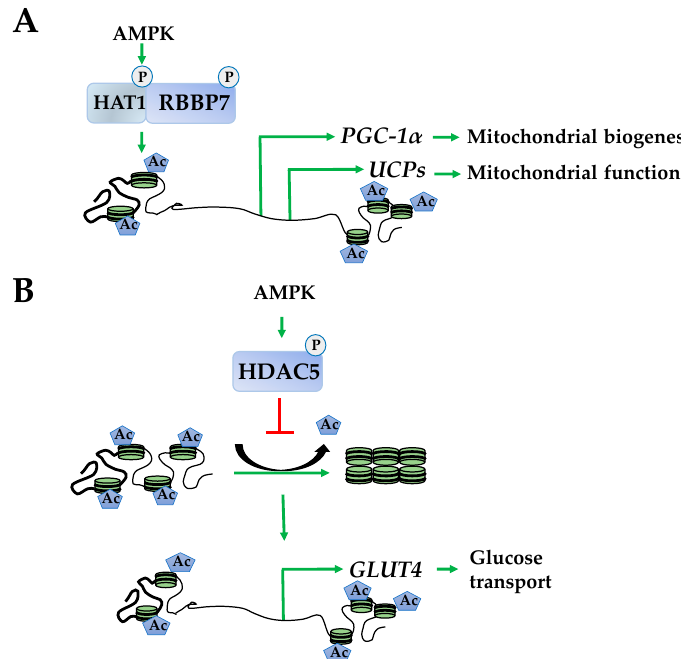
Figure 3. AMPK inhibits histone deacetylase activity to promote histone acetylation. ( A ) AMPK phosphorylates histone acetylase1 and retinoblastoma binding protein 7 (RBBP7) to form a complex that acetylates histones at promoters of peroxisome proliferator-activated receptor gamma coactivator-1 α ( PGC-1 α ), uncoupling proteins ( UCPs ) to increase mitochondrial biogenesis and function; ( B ) AMPK phosphorylates and inhibits HDAC5 enhancing acetylation at the glucose transporter type 4 ( GLUT-4 ) promoter increasing its transcription.